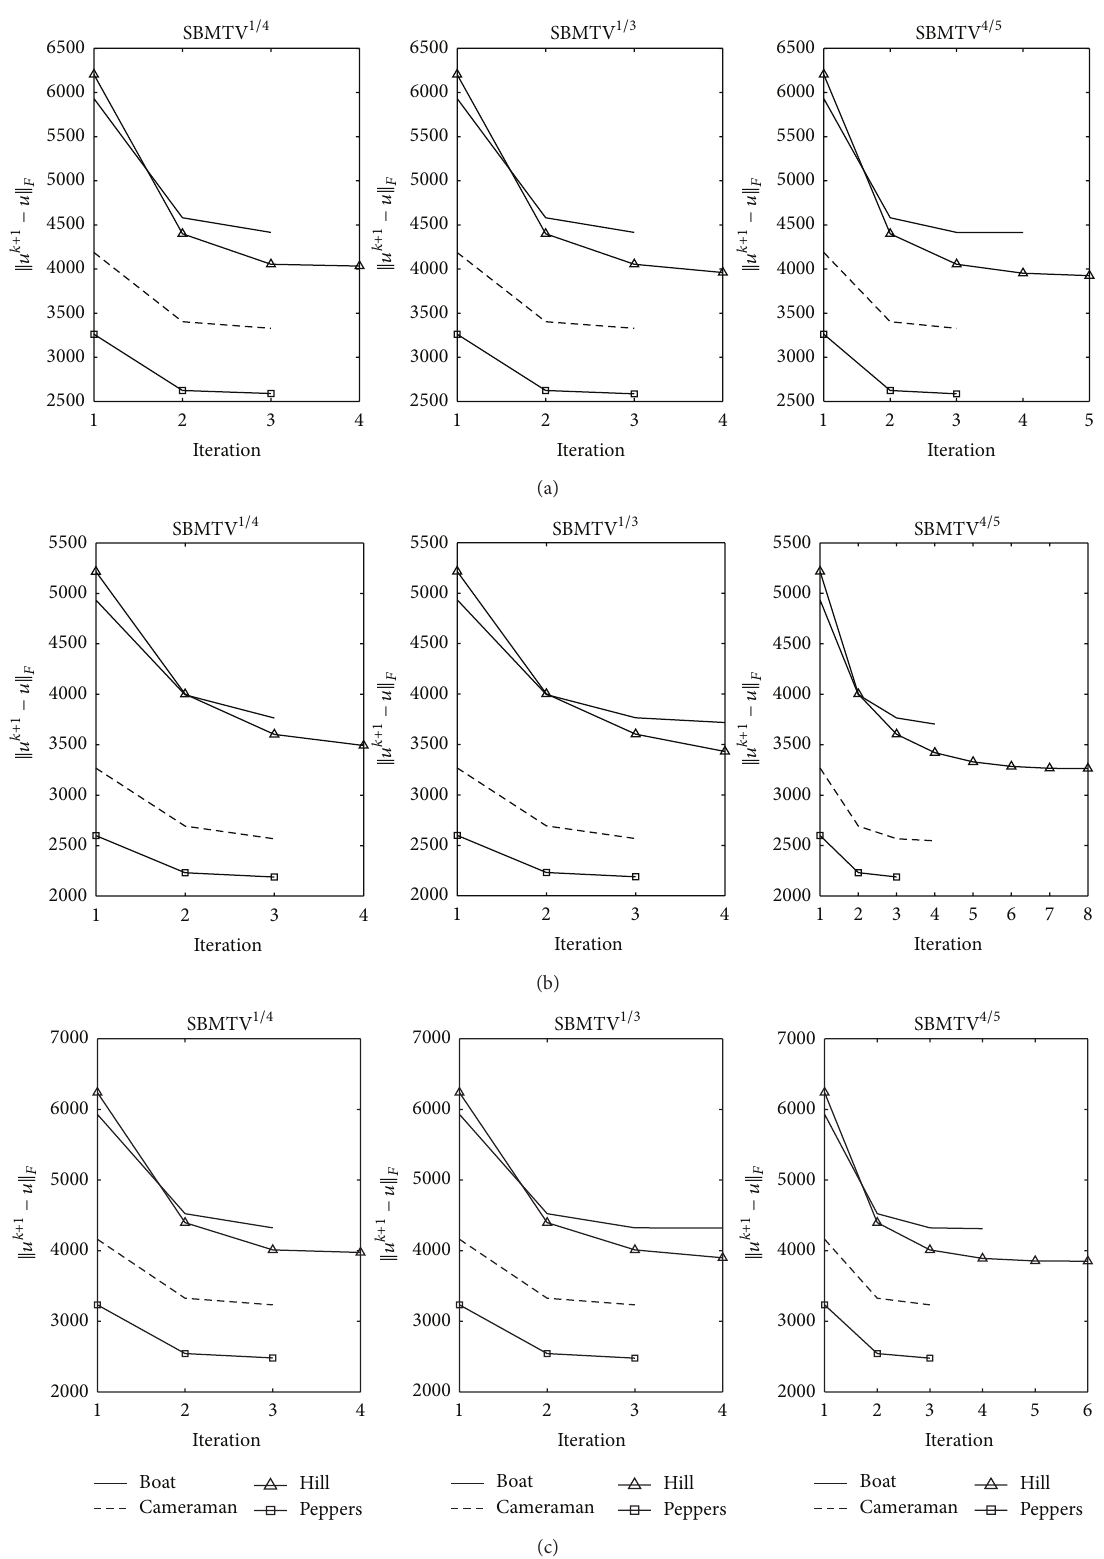
Figure 6: Evolution of ‖𝑢 𝑘+1 − 𝑢‖ 𝐹 of SBMTV 𝑝 in the procedure of iteration; (a) evolution of ‖𝑢 𝑘+1 − 𝑢‖ 𝐹 when restoring Gaussian blurred- noisy images; (b) evolution of ‖𝑢 𝑘+1 − 𝑢‖ 𝐹 when restoring motion blurred-noisy images; (c) evolution of ‖𝑢 𝑘+1 − 𝑢‖ 𝐹 when restoring average blurred-noisy